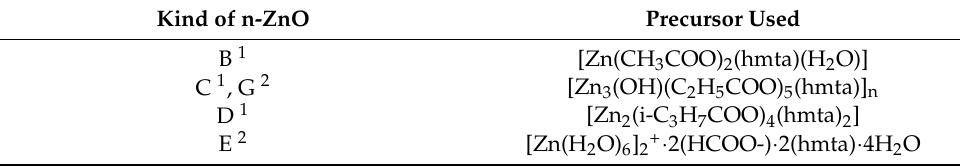
Table 4. Types of precursors and the parameters for n-ZnO synthesis [13,14]. Kind of